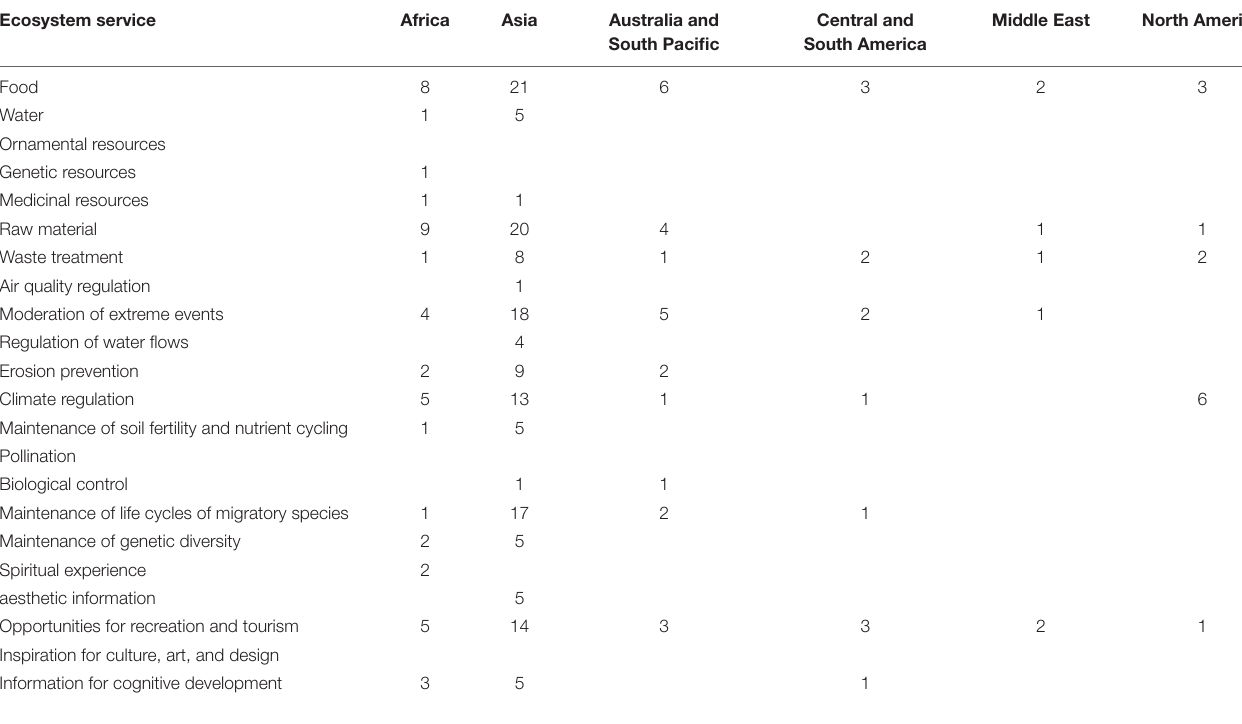
TABLE 3 | Count of studies published between 2007 and 2016 that valued each ecosystem service category by region of the case study. Ecosystem